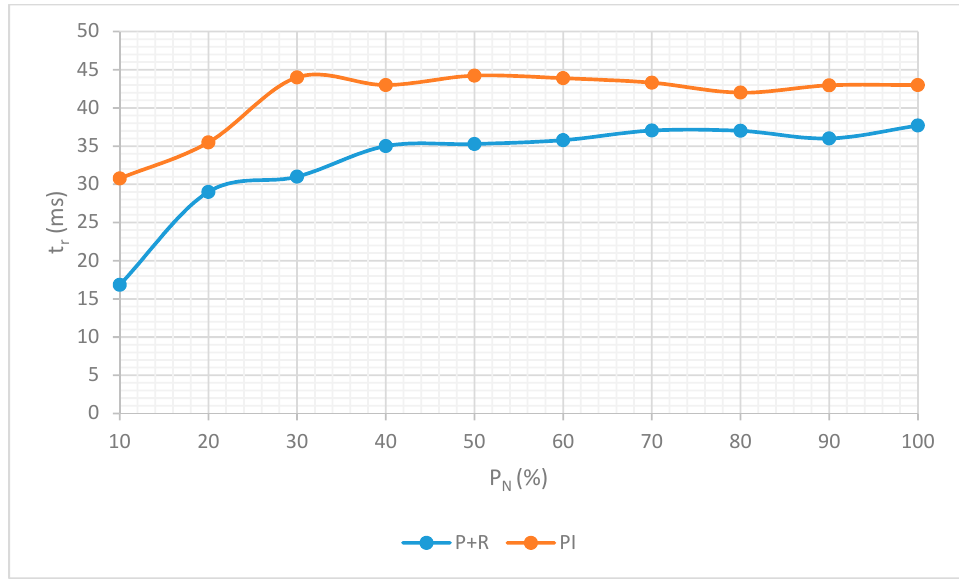
Figure 21. Comparison of adjustment times of P+R and PI controllers in the tested system, for changes in the character of the reactive